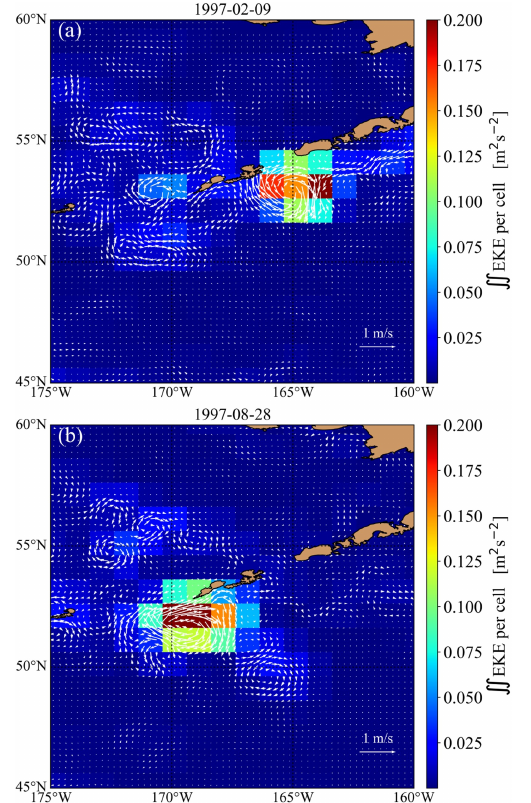
Figure 10. Snapshots of the geostrophic flow field and integrated kinetic energy (color scale is linear) for two time instances in the northern Pacific region analyzed in Fig. 9c. (a) 9 February 1997 (day 1500 in Fig. 9c). (b) 200d later on 28 August 1997 (day 1700 in Fig. 9c). The radius of the huge anticyclonic vortex has a length around 300–350km (note that the apparent elongation is the conse- quence of equidistant cylindrical map